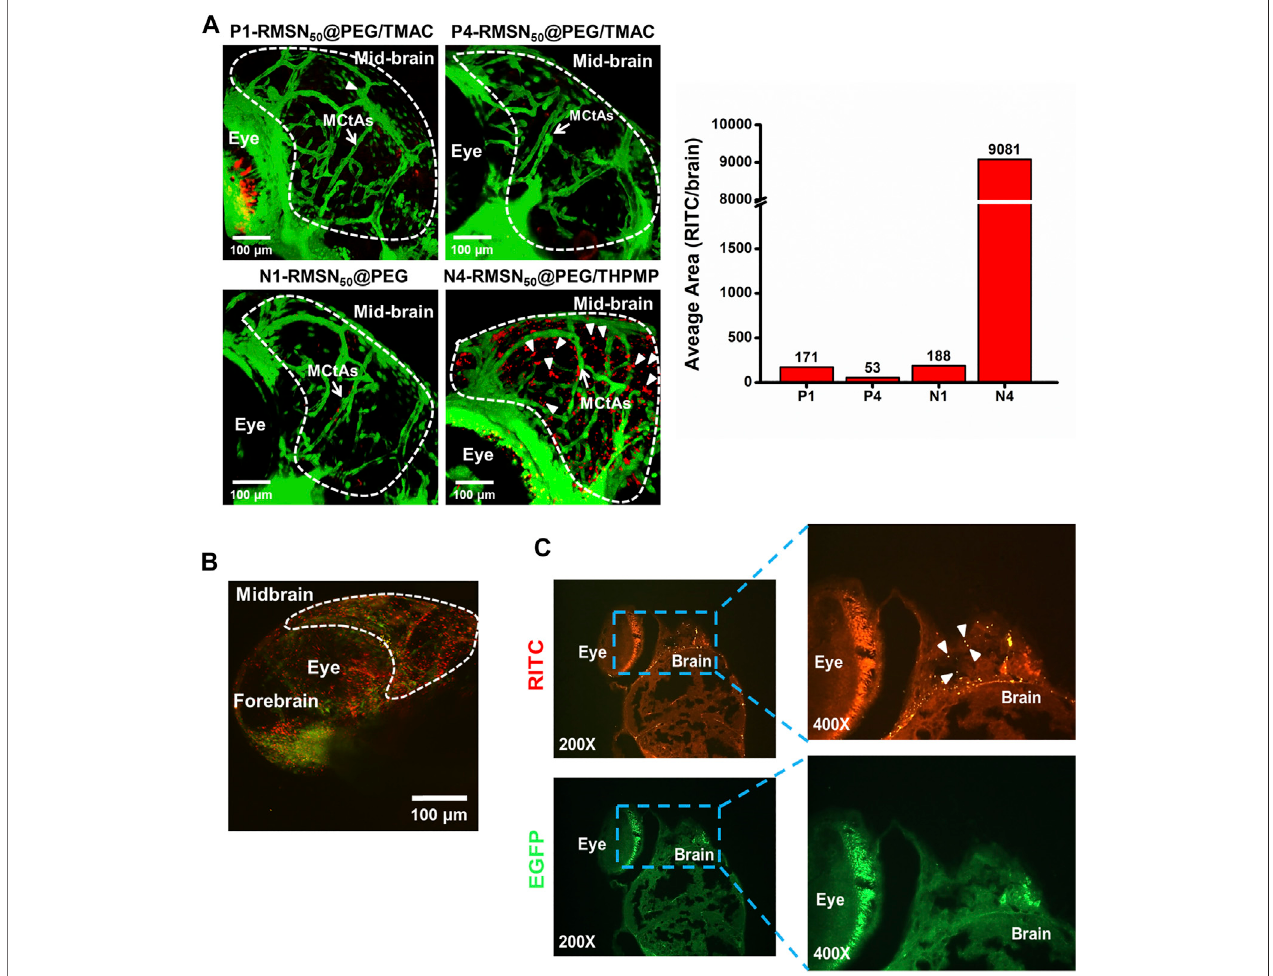
FIGURE2| BiodistributioninthebrainoffourtypesofRITC-conjugatedmesoporoussilicananoparticles(RMSNs)afterapericardialcavityinjectionin Tg ( z fl i1 :EGFP transgeniczebra fi sh(200 – 300 ng/embryo)at4 dayspost-fertilization(dpf). (A) Confocalmicroscopyimagedthedistributions ofvarioustypesofRMSNsinthezebra fi sh larval brain.Thewhitearrowindicatesmesencephalic central arteries (MCtAs).ArrowheadsindicatethatRMSNs(red) wereoutside thebrain ’ sblood vessels(green). (B) Two-photonmicroscopicimagesand (C) fl uorescencemicroscopicanalysisofzebra fi shembryobrainsafterinjectionwithN4-RMSN 50 @PEG/THPMP.Red(RITC) fl uorescence and green (GFP) fl uorescence, respectively, represent RMSNs and blood vessels. Arrowheads indicated RMSNs (red).